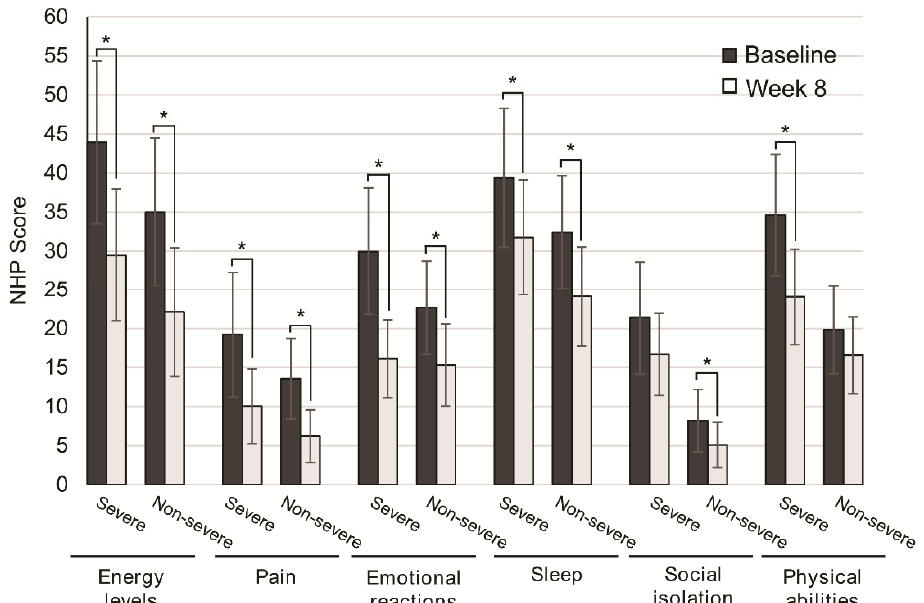
Figure 3. Change in quality of life after 8 weeks of oligomeric enteral nutrition (OEN) by disease severity. The bars show mean scores ± 95% CI for each category of the Nottingham Health Profile at baseline and after 8 weeks of OEN treatment for patients with or without disease severity. * indicates p < 0.05 (from baseline to Week 8). The NHP score ranges from 0 (does not perceive any health problem) to 100 (maximum health problems perceived by the patient).